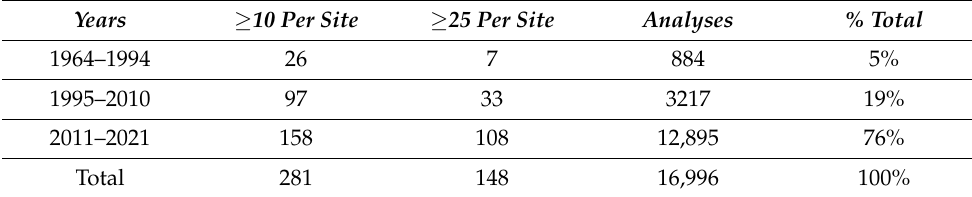
Table 1. Analyses of obsidian artifacts in the central Mediterranean. Years ≥ 10 Per Site ≥ 25 Per Site Analyses %